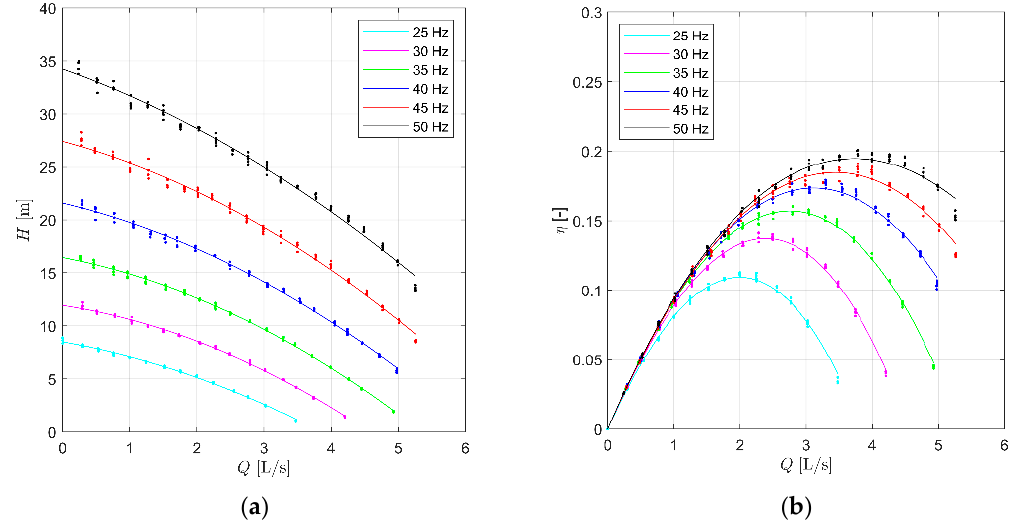
Figure 6. Characteristic ( a ) and efficiency ( b ) curves of a pump affected by a medium wear.